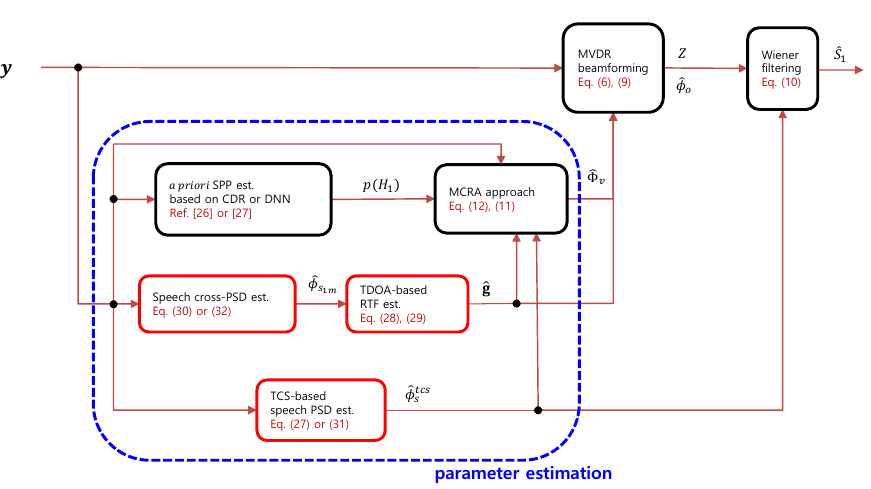
Figure 2. Block diagram of the proposed multi-microphone speech enhancement